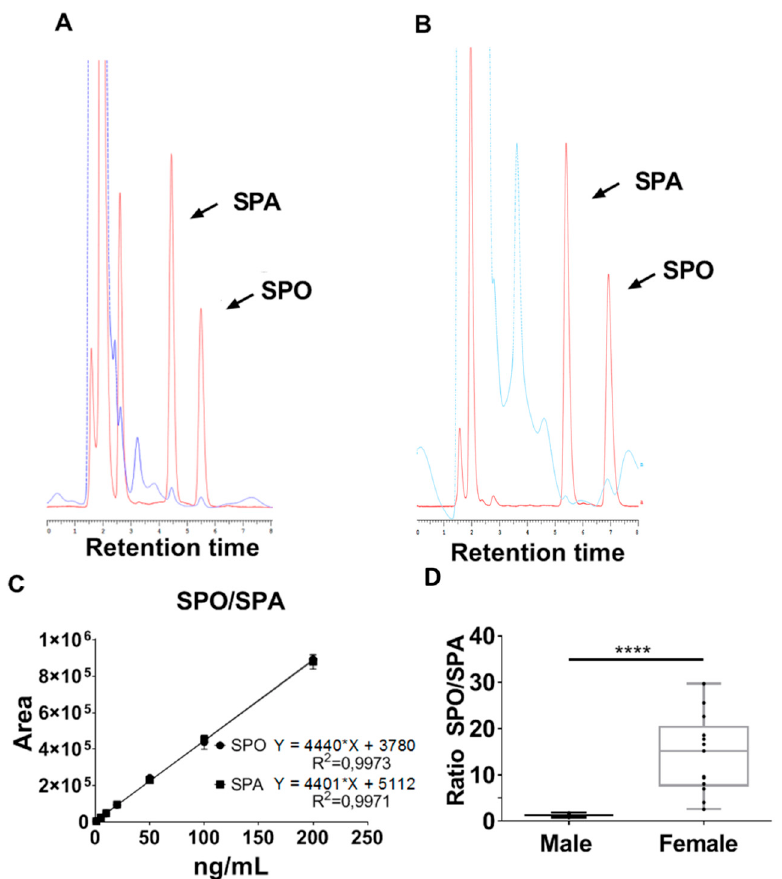
Figure 2. Chromatogram showing sphinganine and sphingosine with retention times of 4.6 min and 5.6 min in red, respectively, and a representative male serum sample in dark blue ( A ). A representative female serum sample shown in light blue, with sphinganine and sphingosine having a retention time of 5.5 min and 7.0 min, respectively. The standard is shown in red ( B ). Standard curves for sphinganine and sphingosine ( C ). The high-performance liquid chromatography (HPLC) analysis of sphingosine (SPO) and sphinganine (SPA) in serum samples from male and female rats. The results are presented as the ratio of sphingosine/sphinganine ( D ). Statistical analysis performed by a one-way t-test. **** p ≤ 0.0001, data shown are of at least 10 independent samples. Results are presented as standard error of the mean